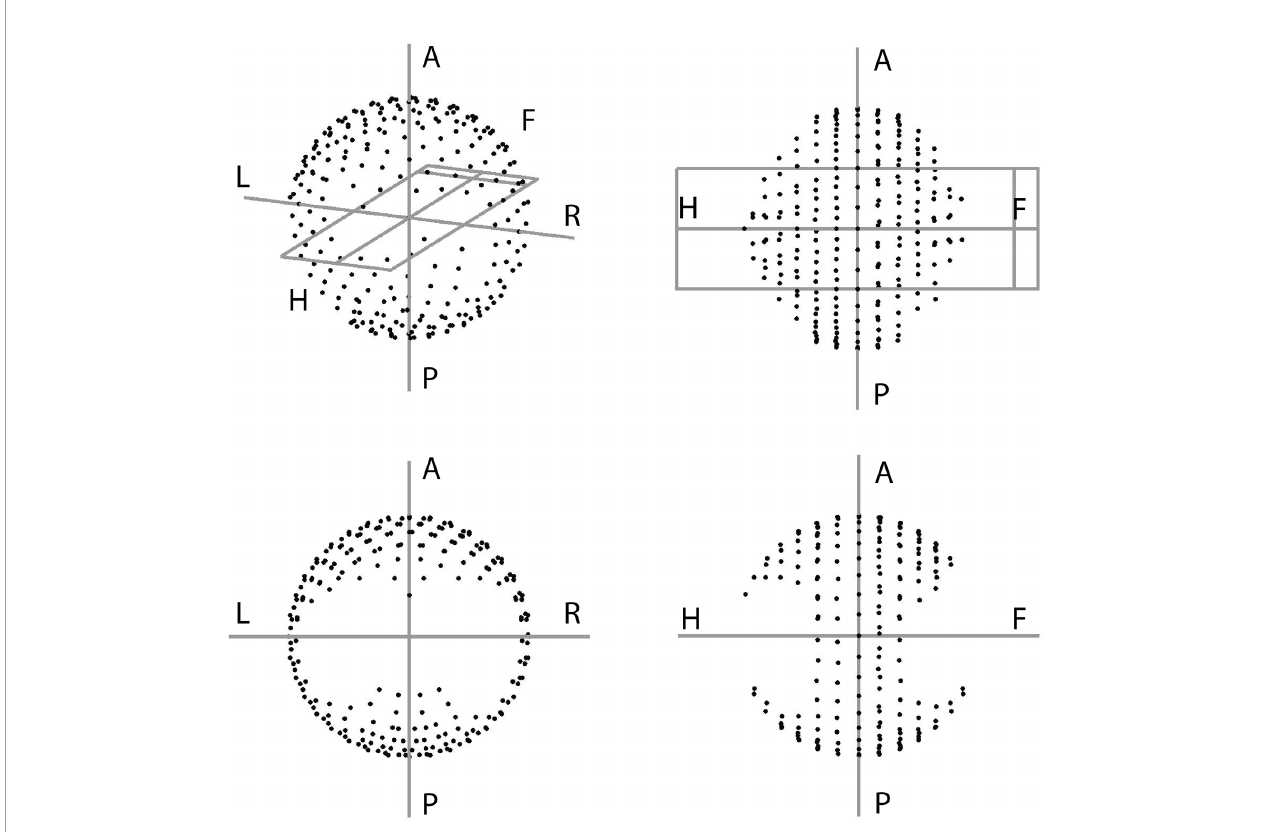
FIGURE 1 | The full beam-angle search space for linac-based prostate SBRT planning as de fi ned on our treatment unit using head and knees supporting